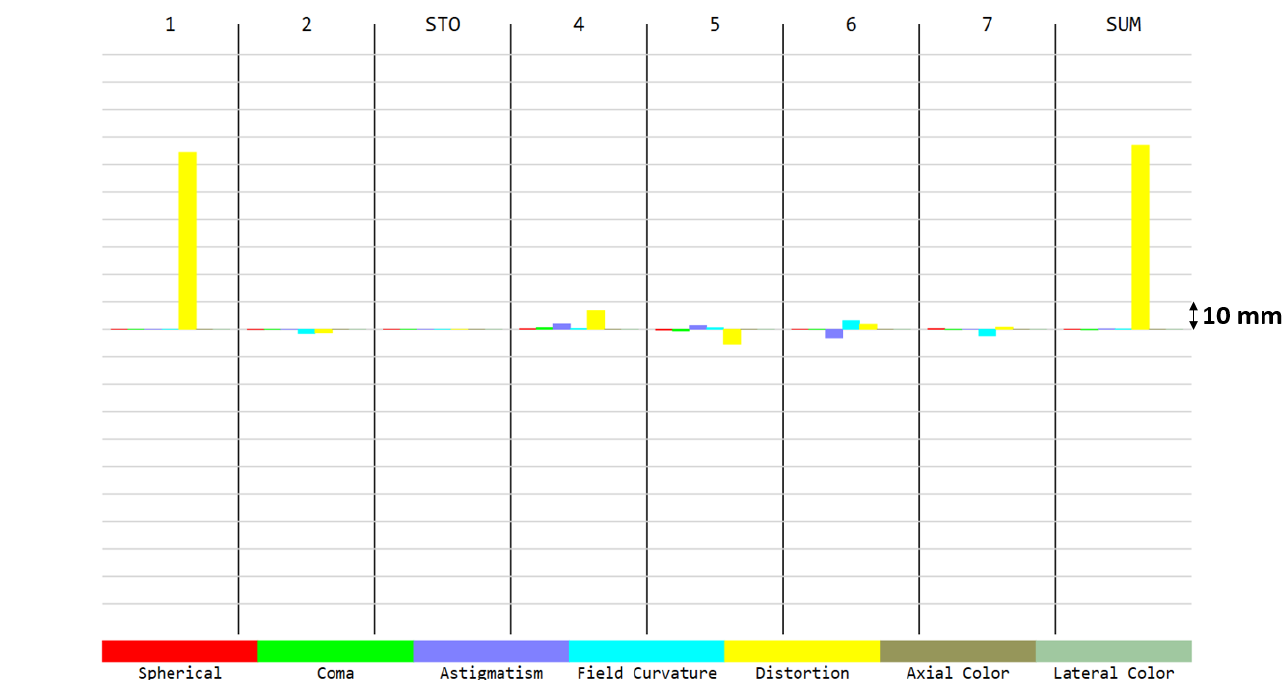
Figure 4. Five Seidel aberrations and (axial and lateral) chromatic aberrations. The aberrations are given for each surface involved in the optical system (1 and 2 for the first lens, 3 = STO i.e., the stop aperture, 4 and 5 for the second lens, 6 and 7 for the third lens). The SUM represents the sum of these aberrations at the image plane. The main aberration is the barrel distortion, mainly induced by Surface 1, i.e., the front surface of the first lens. The barrel distortion is further detailed in Figure 5. The same aberration contributions were observed for all wavelengths between 8 and 14 µ m.